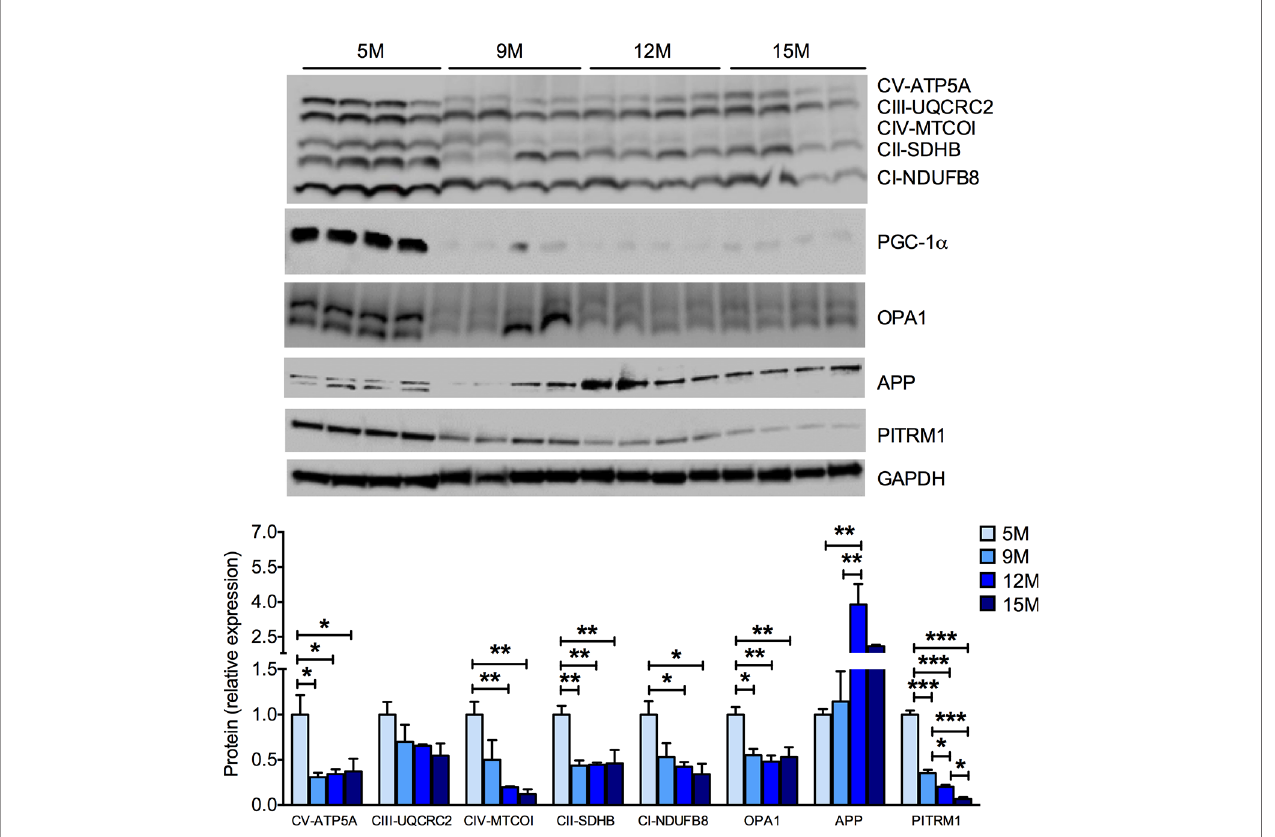
FIGURE 3 | Progressive mitochondrial dysfunction and impaired proteostasis in the hippocampus of SAMP8 mice. Western blot analysis of hippocampal homogenates shows an age-dependent decrease of the mitochondrial respiratory chain (MRC) subunits ATP5A (complex V or ATP synthase), UQCRC2 (complex III), MT-COI (complex IV), SDHB (complex II), and NDUFB8 (complex I). The mitochondrial-shaping protein OPA1 was also reduced with aging. In parallel, SAMP8 mice hippocampi showed a signi fi cant increase of amyloid precursor protein (APP) and a decrease of the pitrilysin metallopeptidase 1 (PITRM1) protein levels. The quanti fi cation of each signal per group were normalized to the amount of GAPDH and represented below the Western blot images. Statistical analysis was performed with one-way ANOVA and Tukey ’ s multiple comparison test; error bars represent SEM; n=4 mice/group; *p < 0.05, **p < 0.01, ***p <